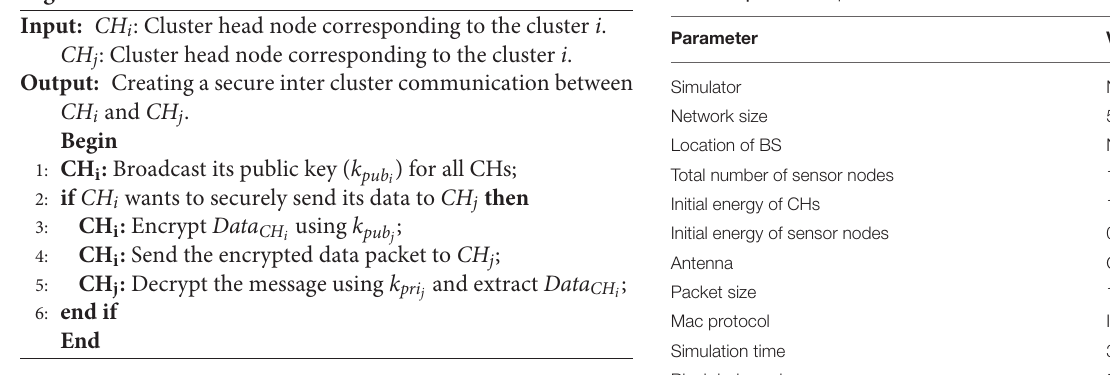
TABLE 1 | Simulation